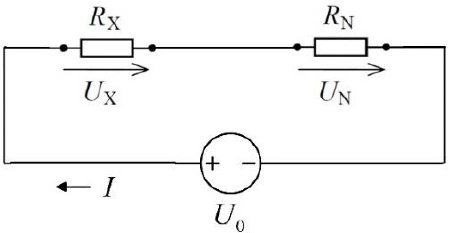
Figure 2. Equivalent circuit of a voltage resistive divider with two resistors.